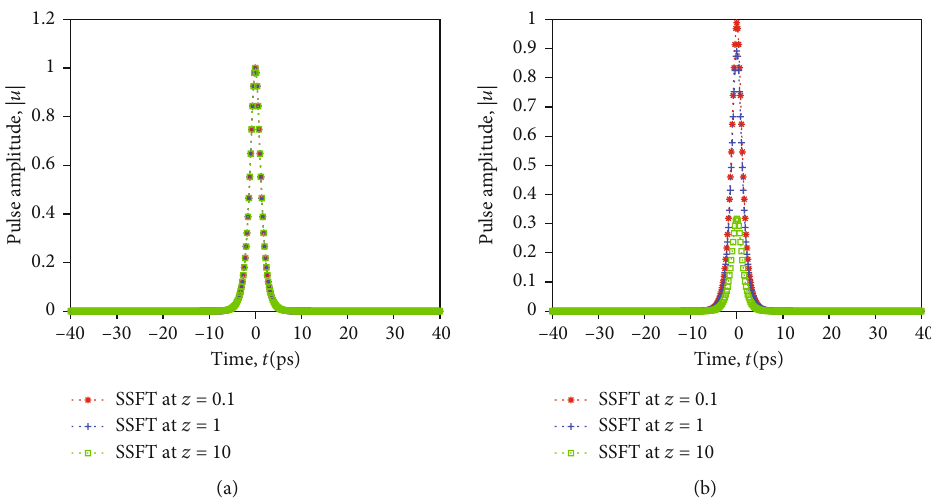
= − 20 ps 2 /km for a 2